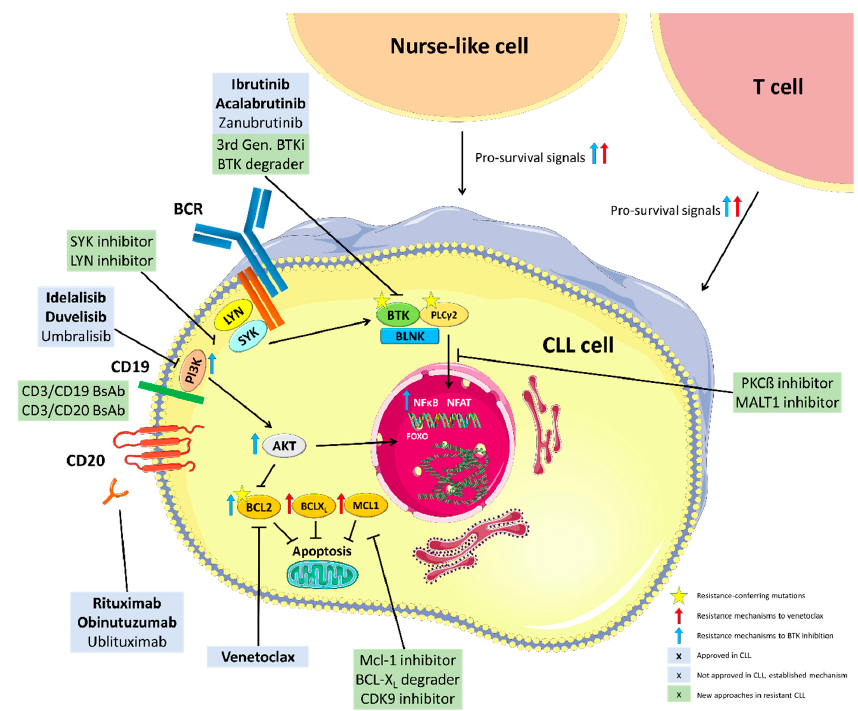
Figure 1. Mechanisms of resistance to BTK and Bcl-2 inhibition and targets of approved and experimental treatment approaches. BCR: B cell receptor, PI3K: Phosphoinositide 3-kinase, BTK: Bruton’s Tyrosine Kinase, PLCy2: Phospholipase gamma 2, BLNK: B cell linker protein, PKCß: Protein kinase C beta, MALT1: Mucosa-associated lymphoid tissue lymphoma translocation protein 1, Mcl-1: myeloid cell leukemia 1, BCL-XL: B-cell lymphoma-extra large, CDK9: Cyclin-dependent kinase 9, Bcl-2: B-cell lymphoma 2, NFkB: Nuclear factor kappa B, FOXO: Forkhead transcription factors, NFAT: Nuclear factor of activated T-cells, BsAb: Bispecific Antibody. This figure was produced by Moritz Fürstenau using servier medical art (smart.servier.com, accessed on 1 February